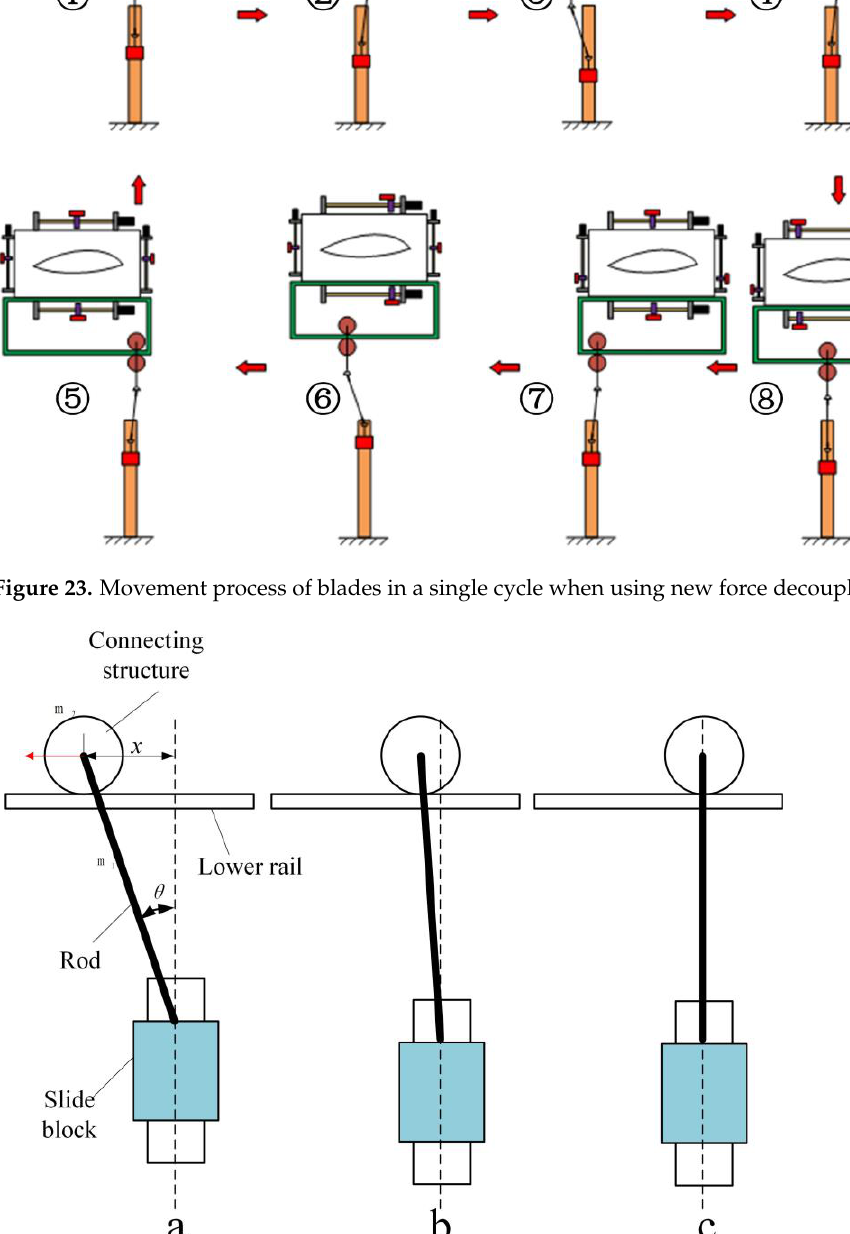
Figure 24. Horizontal force diagram of connecting structure. ( a – c ) are infinite friction, normal friction and no friction respectively. (1) When the rolling bearing rotates